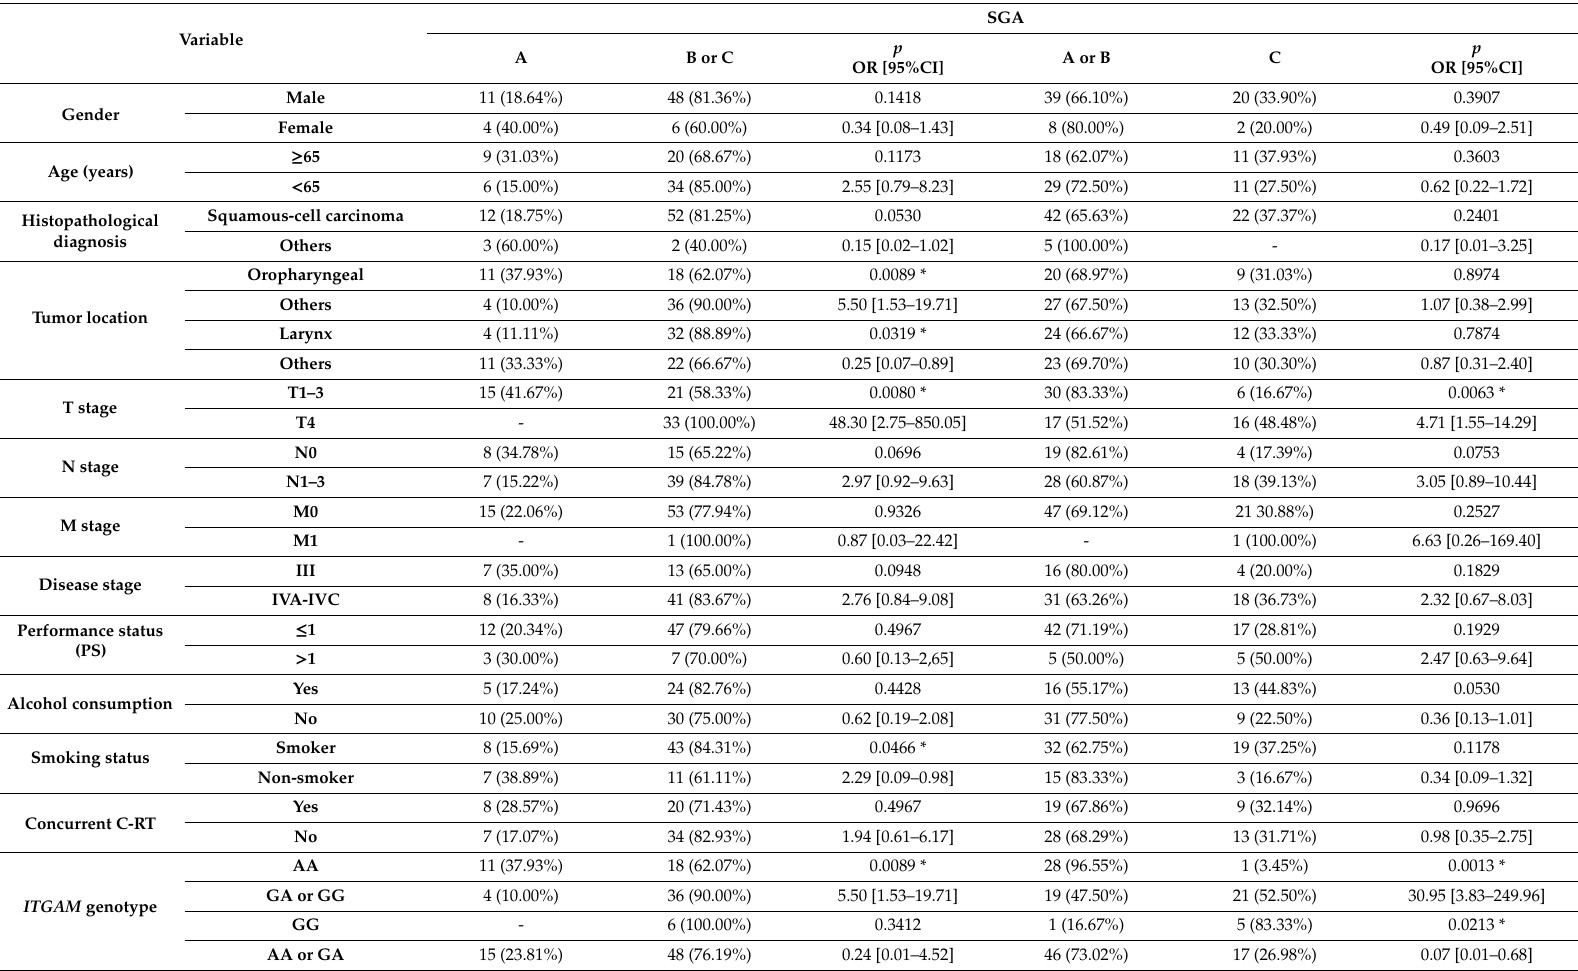
Table 2. Impact of the clinical-demographic, nutritional and genetic factors on the subjective global assessment (SGA)